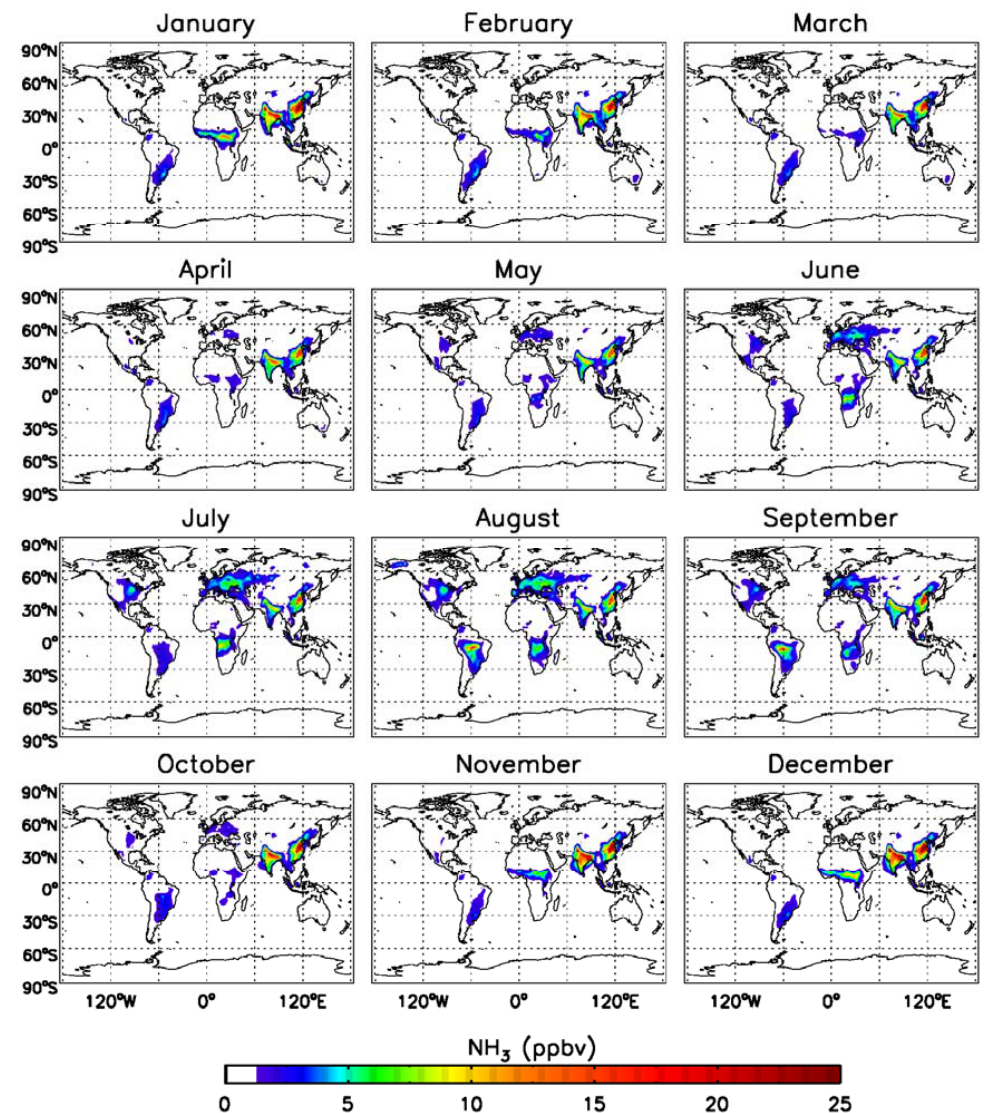
Fig. 2. GEOS-Chem monthly mean surface NH 3 mixing ratio Figure 1. GEOS-Chem monthly mean surface NH3 mixing ratio amounts.